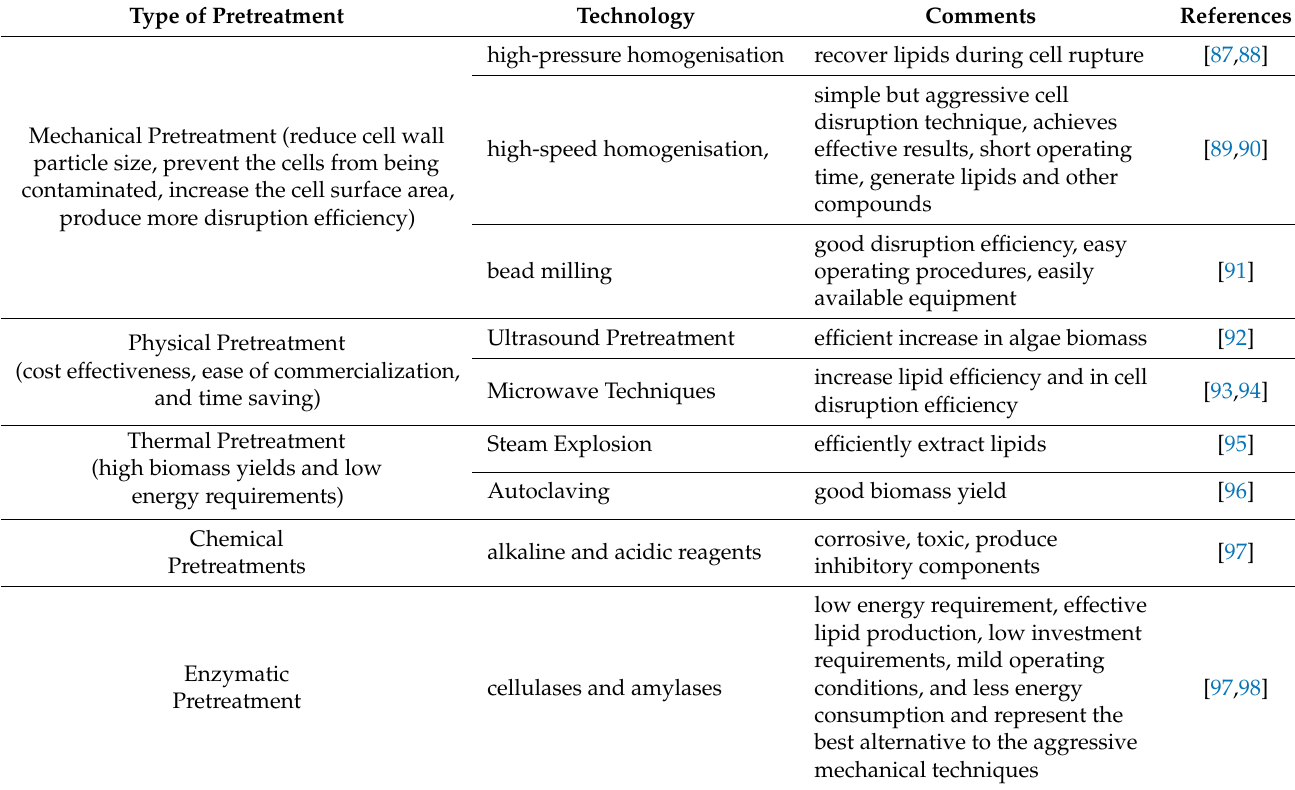
Table 3. Different types of algae biomass pretreatment